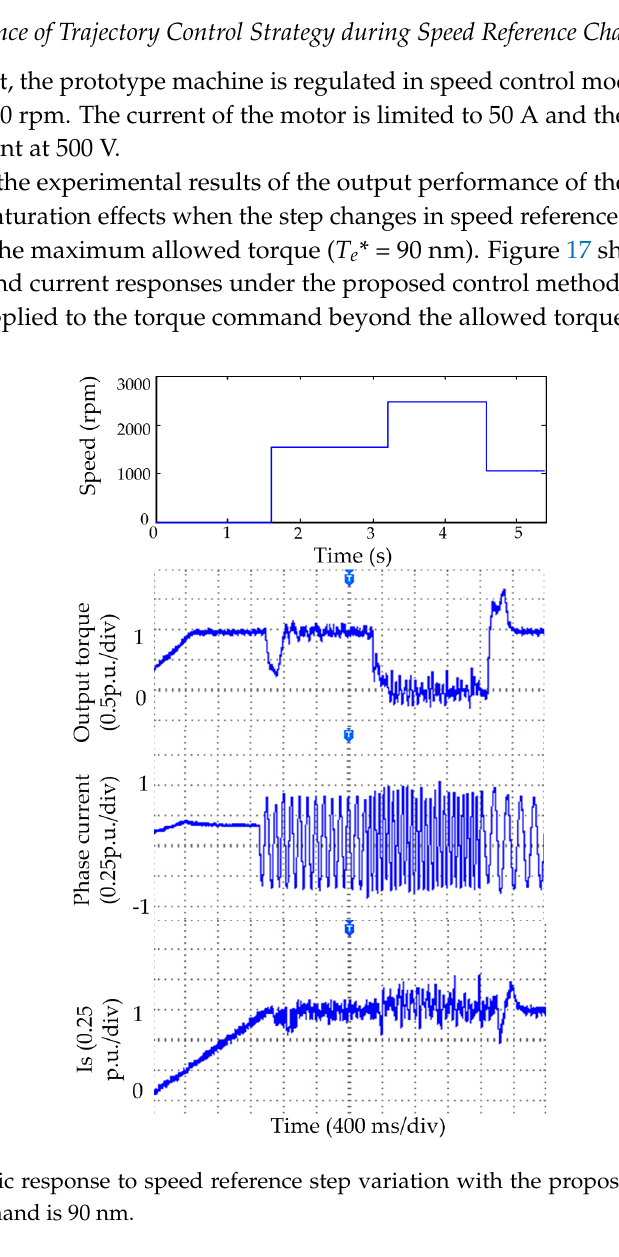
Figure 16. Dynamic response to speed reference step variation with the proposed control strategy when torque command is 90 nm.